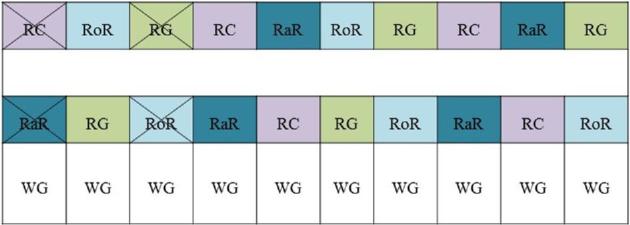
Distribution of the broiler genotypes Ranger Classic (RC), Ranger Gold (RG), Rowan Ranger (RoR), and Rambler Ranger (RaR) in the pens. Crossed pens are excluded from analysis. WG = winter garden.